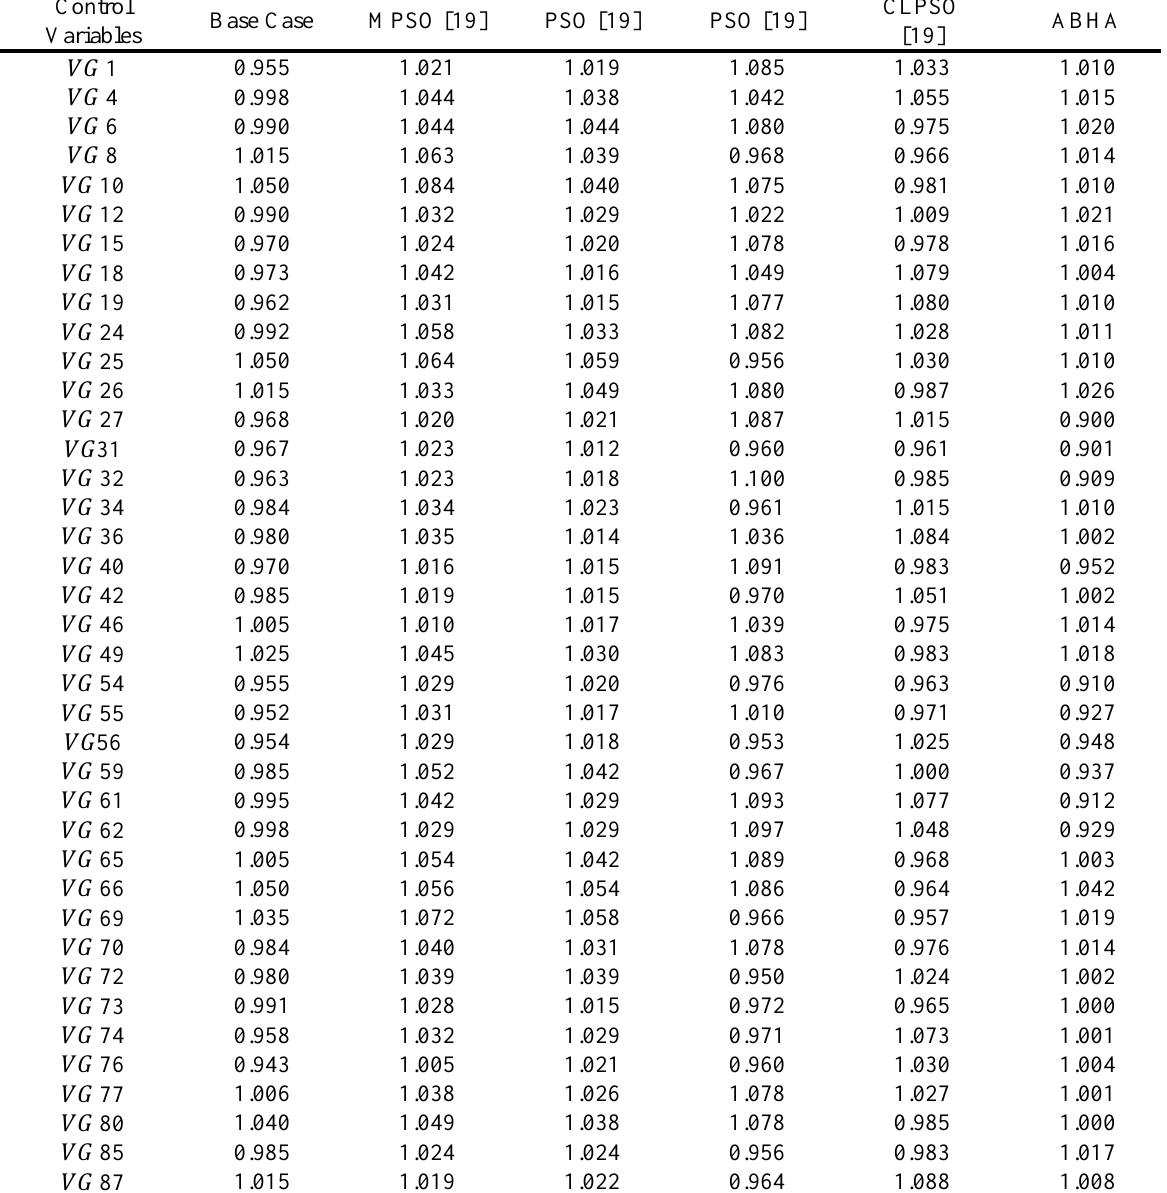
Table 11. Simulation results of IEEE −118